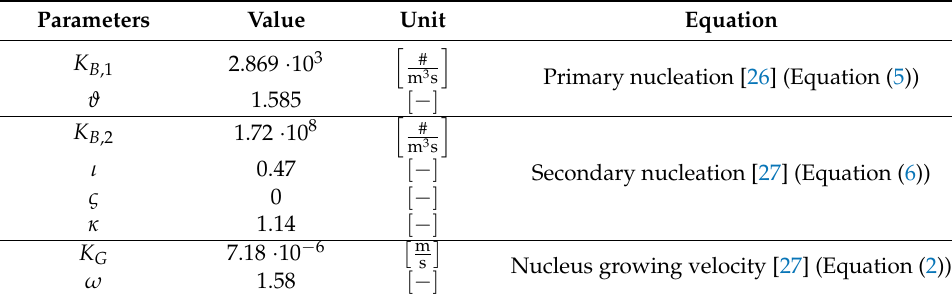
Table 1. Parameters of kinetic equations.